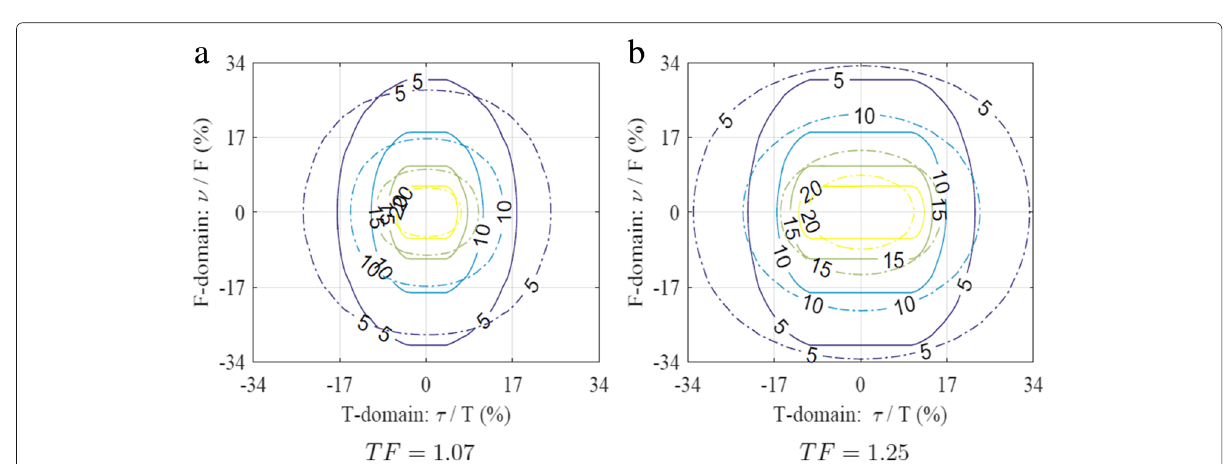
Fig. 8 a , b SIR contour for orthogonal pulse design ( dashed ) and CP-OFDM ( solid